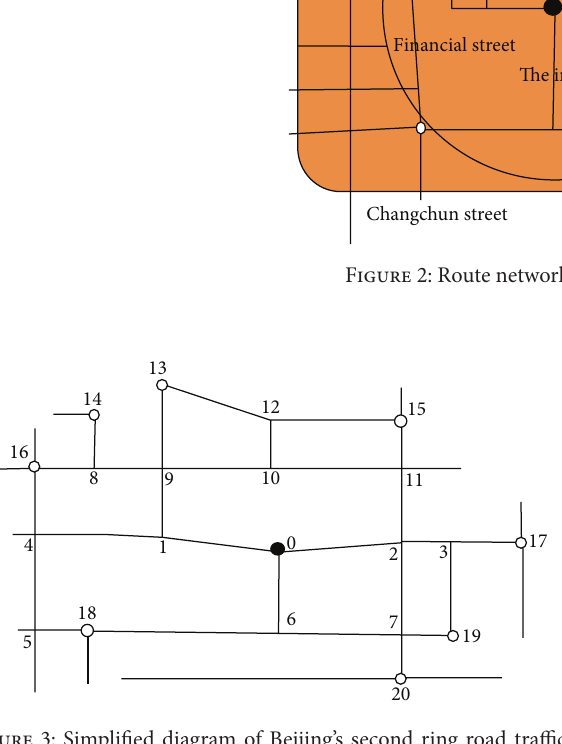
Figure 3: Simplified diagram of Beijing’s second ring road traffic